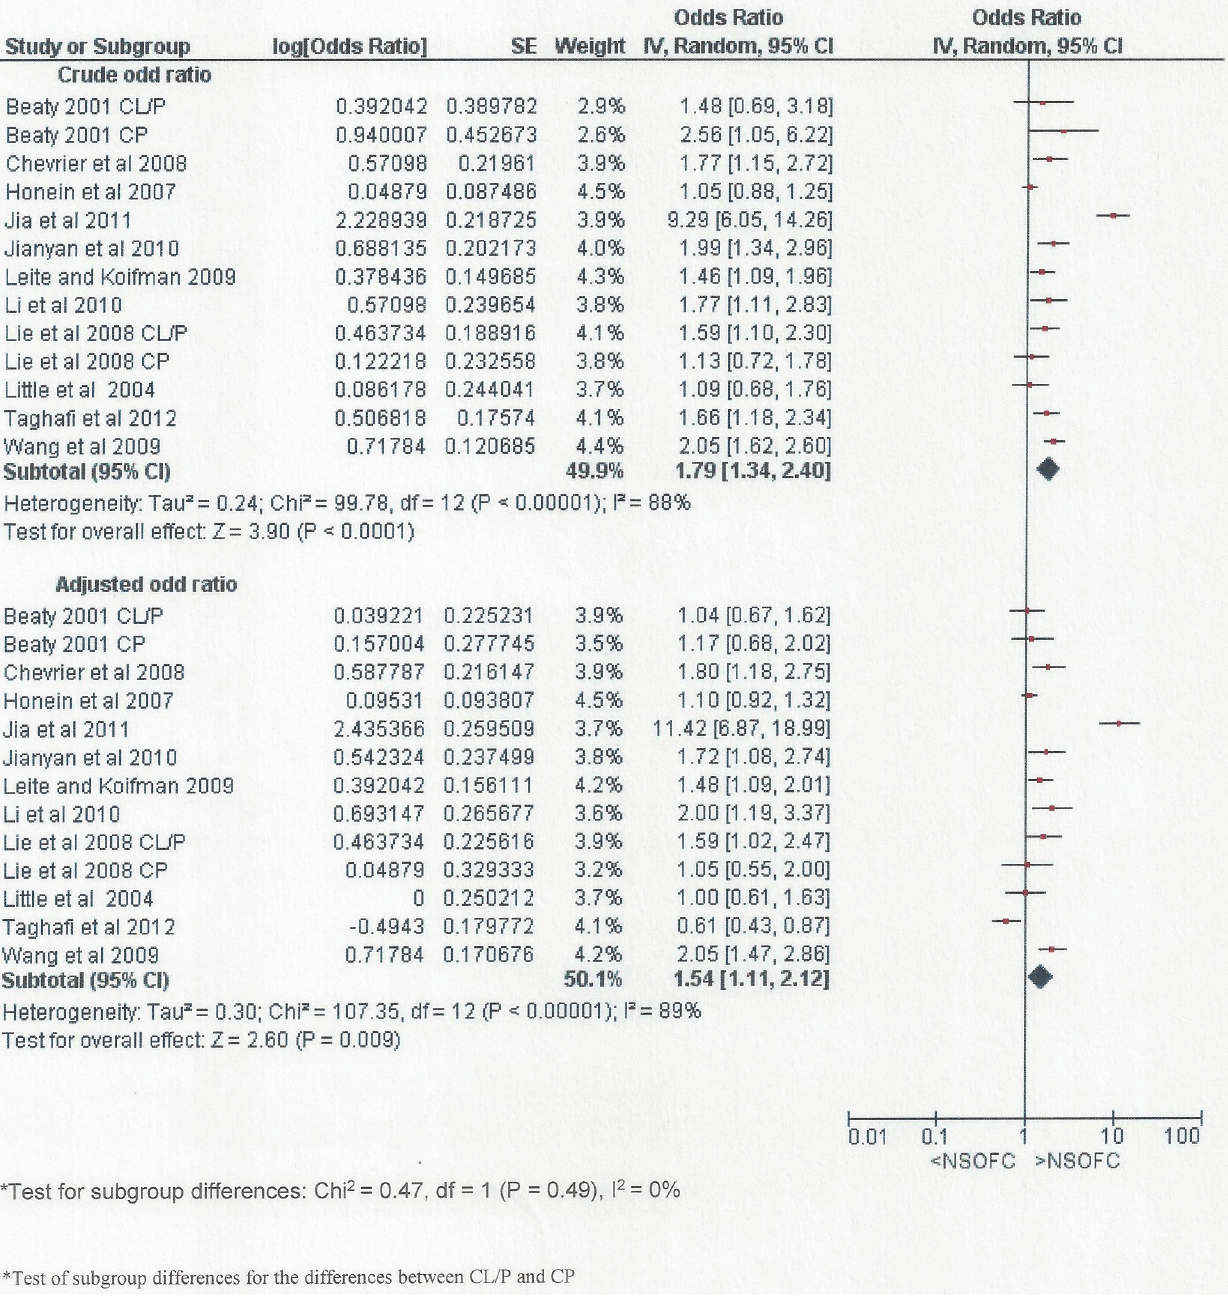
Fig 4. Forest plot for meta-analysis showing the crude and reported adjusted OR for the association between maternal passive smoking and